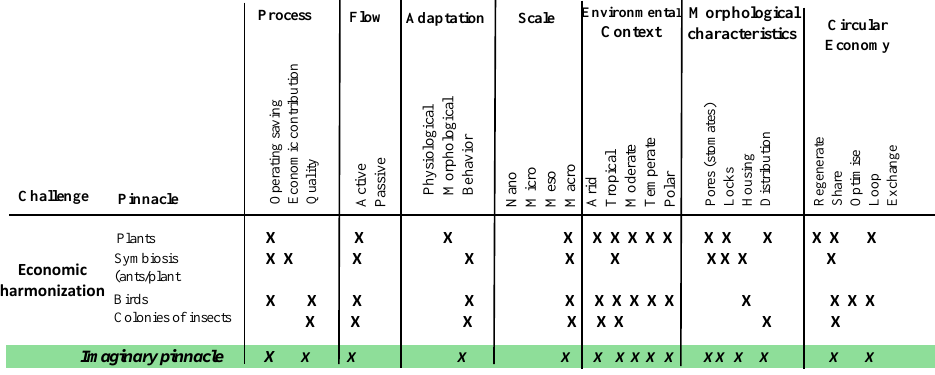
Figure 8. Pinnacles Matrix Analysis for the Economic harmonization Challenge.